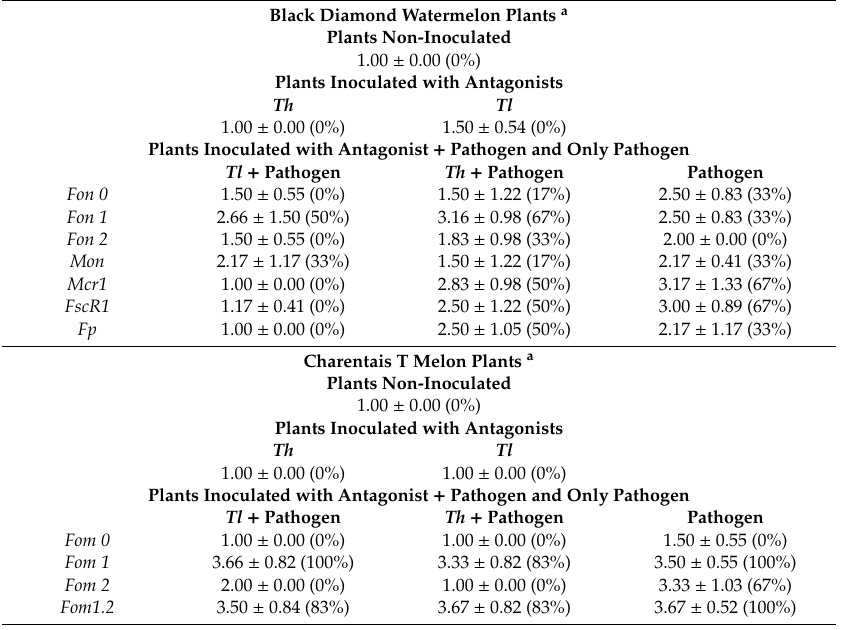
Table 7. Degree of symptomatology of ‘Black Diamond’ watermelon and ‘Charentais T’ melon plants inoculated with Trichoderma harzianum ( Th ) and Trichoderma lentiforme ( Tl ) alone and in combination ( Tl + pathogen and Th + pathogen) with Fon 0, Fon 1, Fon 2, Mon, Mcr1, Fsc R1 , and Fp (watermelon), and Fom 0, Fom 1, Fom 2, and Fom 1.2 y (melon), respectively. Degree of symptomatology was evaluated using a visual scale from 1 to 4, in the following way: 1 = healthy plants; 2 = stunted growth and damage of up to 50%; 3 = presence of foliar lesions, yellowing, wilting and root damage; 4 = dead plants. Disease incidence (%) is indicated in parentheses.